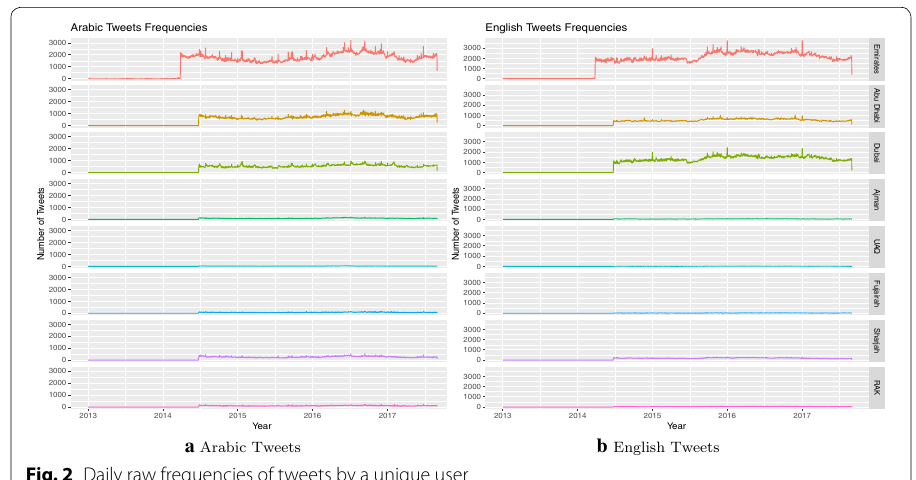
Fig. 2 Daily raw frequencies of tweets by a unique user